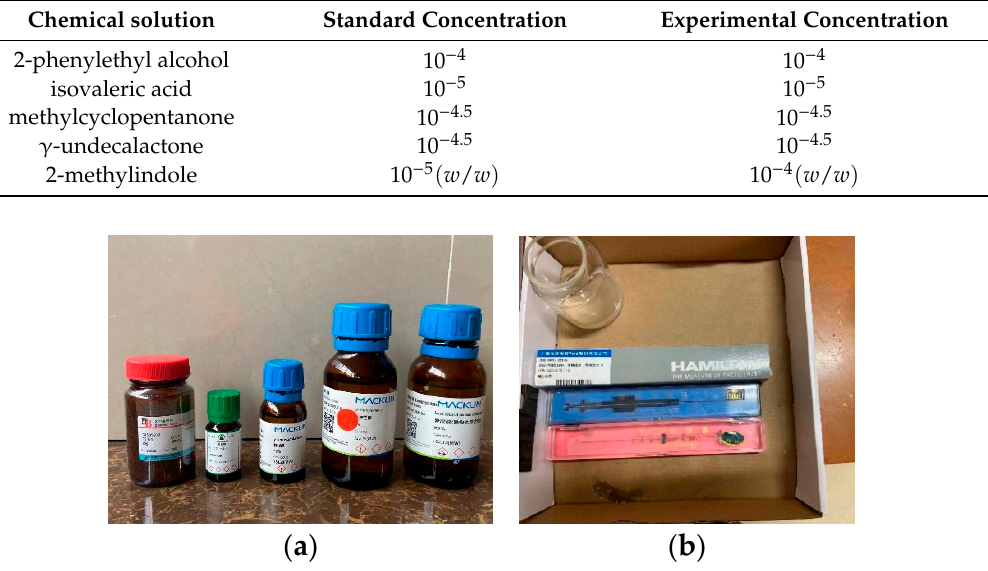
Figure 1. ( a )Actual chemicals. ( b ) Sampling tools: 1-uL, 10-uL, and 0.5-uL needles and a 250-mL beaker. Table 1. Concentration of five kinds of standard